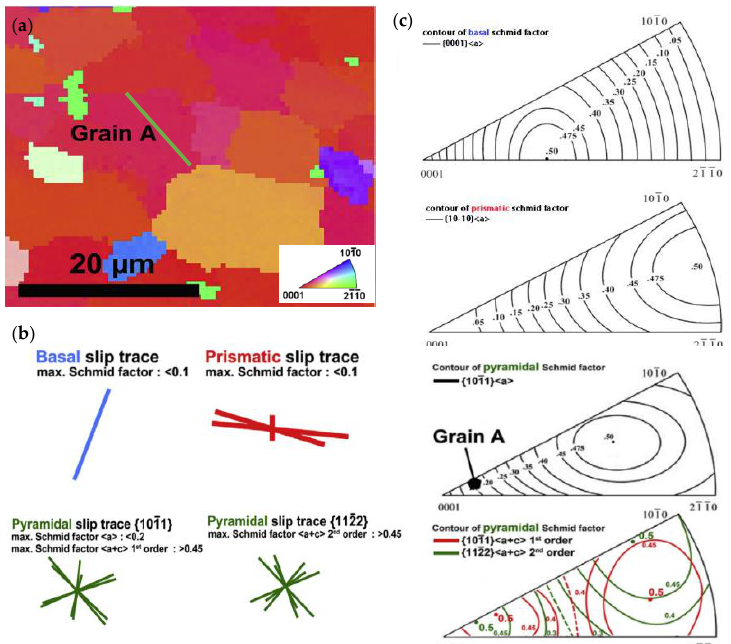
Figure 2. The pyramidal slip system activity in α -grain A: ( a ) position of slip trace in IPF; ( b ) theoretical slip trace; ( c ) distribution of Schmid factor in the triangle and position of grain A [62].